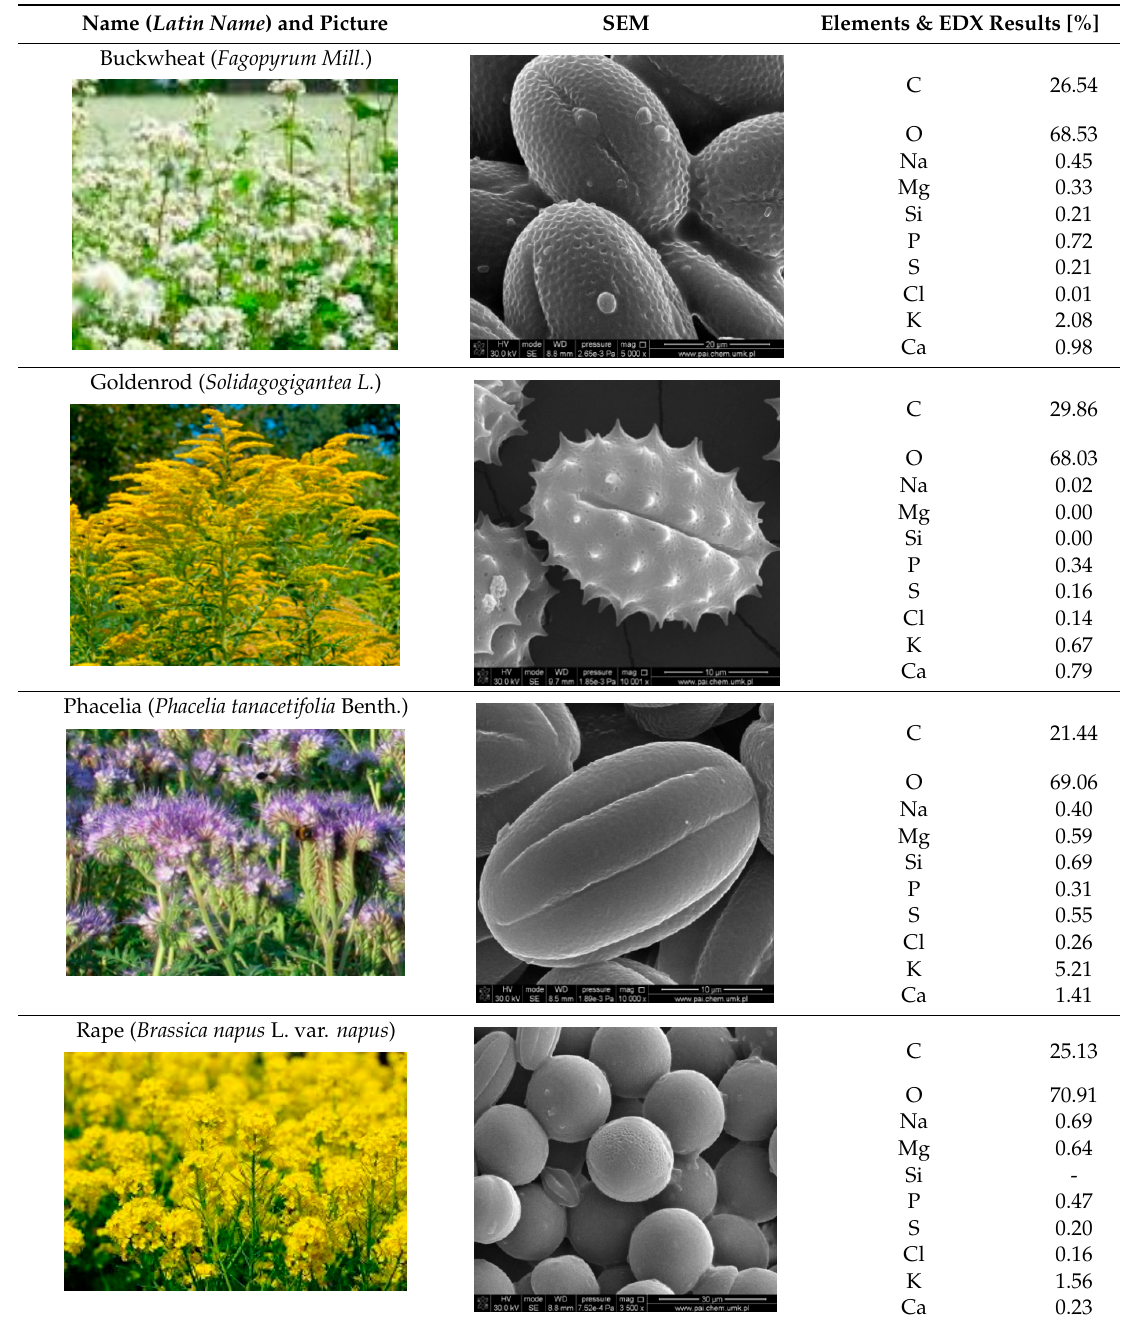
Table 1. General characteristics of pollen grains of selected plants. Name ( Latin Name ) and Picture